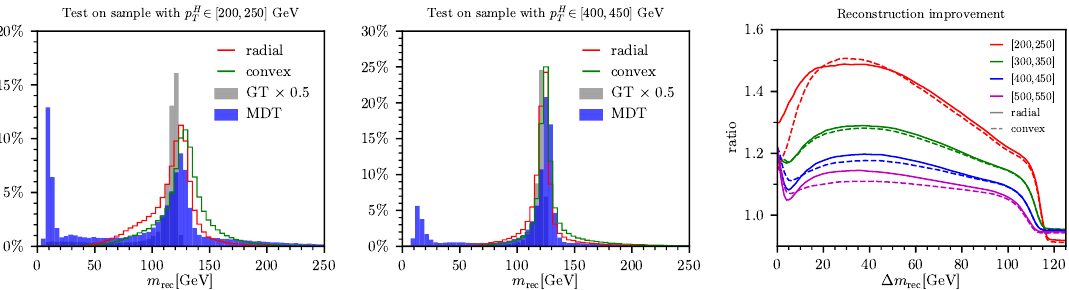
Figure 6. Left and middle panels: reconstructed Higgs invariant mass distributions of event samples with p H in the ranges of [200, 250] GeV and [400, 450] GeV. Right panel: reconstruction T efficiency improvement of CNN over MDT, in terms of the number of reconstructed Higgs within ∆ m of m H . The heights for the distributions of ground truth Higgs mass are rescaled by a factor of 0.5 for